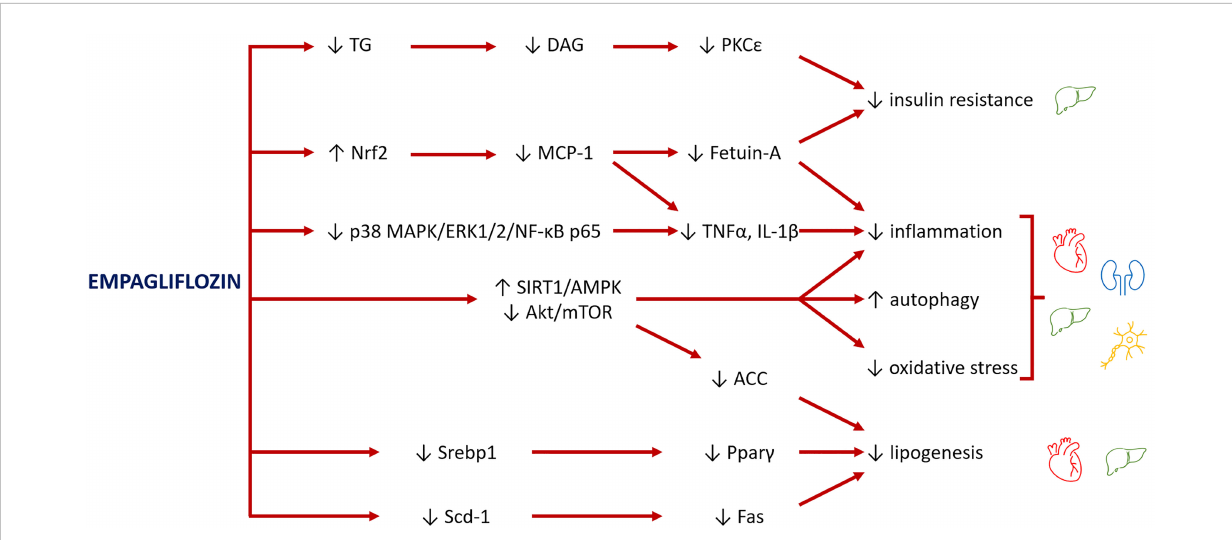
FIGURE 2 Major pathways involved in the rescue of organ damage from empagli fl ozin. Empagli fl ozin reduces insulin resistance by decreasing the levels of triglycerides (TG) and their lipotoxic intermediates diacylglycerols (DAG), lowering the inhibitory effect of PKC ϵ on insulin receptor. Empagli fl ozin also increases levels of Nrf2, a mediator between lipid metabolism and antioxidant defense, with consequent inhibition of MCP-1 and fetuin-A and reduction of in fl ammation and oxidative stress. A further mechanism to inhibit in fl ammation is through suppression of p38 MAPK/ERK1/2/NF- k B p65 expression. The main role of empagli fl ozin is activation of SIRT1/AMPK and inhibition of Akt/mTOR pathways, which reduce in fl ammation, improve mitochondrial function and autophagy, and decrease oxidative stress. Finally, empagli fl ozin reduces the levels of transcription factors (Srebp1 and Ppar g ) and the expression of enzymes (Scd-1, Fas), leading to a reduction of lipogenesis, with bene fi ts especially for the heart and